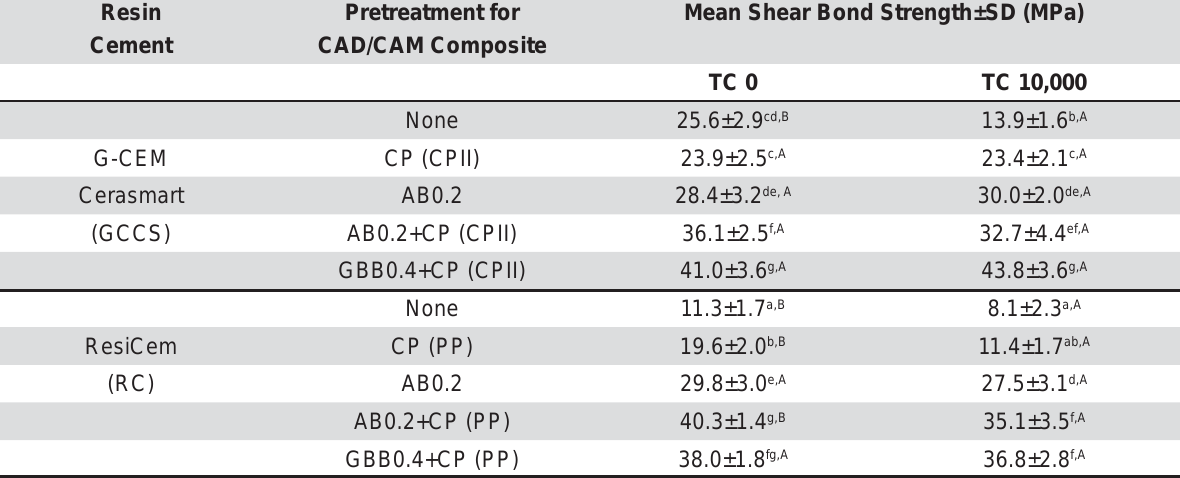
Table 2- Shear bond strength of two resin cements to CAD/CAM composite materials with different pretreatments